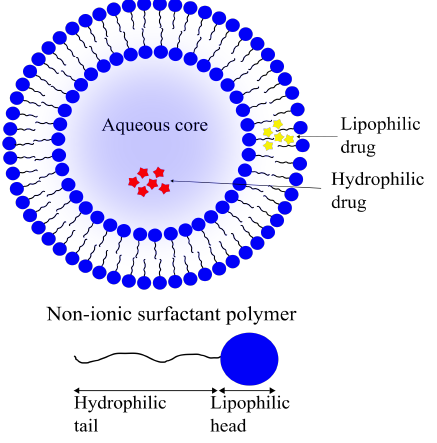
Figure 10. A schematic representation of a niosome formed with amphiphilic, non-ionic surfactants with an aqueous core. Similar to liposomes, lipophilic (yellow) as well as hydrophilic drugs (red) can be encapsulated in